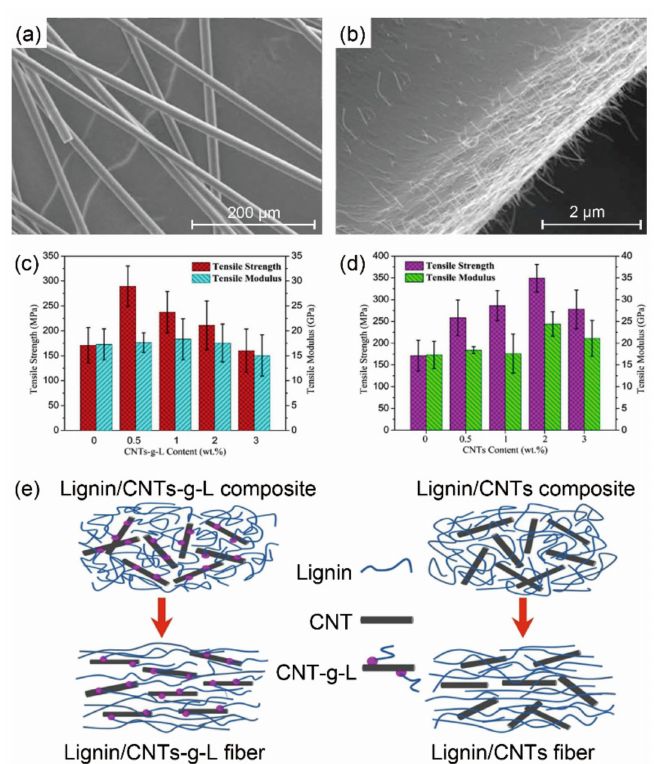
Figure 7. SEM images of 2.5% CNT/lignin fibers ( a ) before and ( b ) after fracture. ( c ) Mechanical properties of lignin/CNTs-g-L- and ( d ) lignin/CNT-based carbon fibers and ( e ) schematic diagram of the orientation of CNTs-g-L and CNTs. ( a , b ) Reproduced with permission from [41], copyright 2013 John Wiley and Sons. ( c – e ) Reproduced with permission from [79], copyright 2016